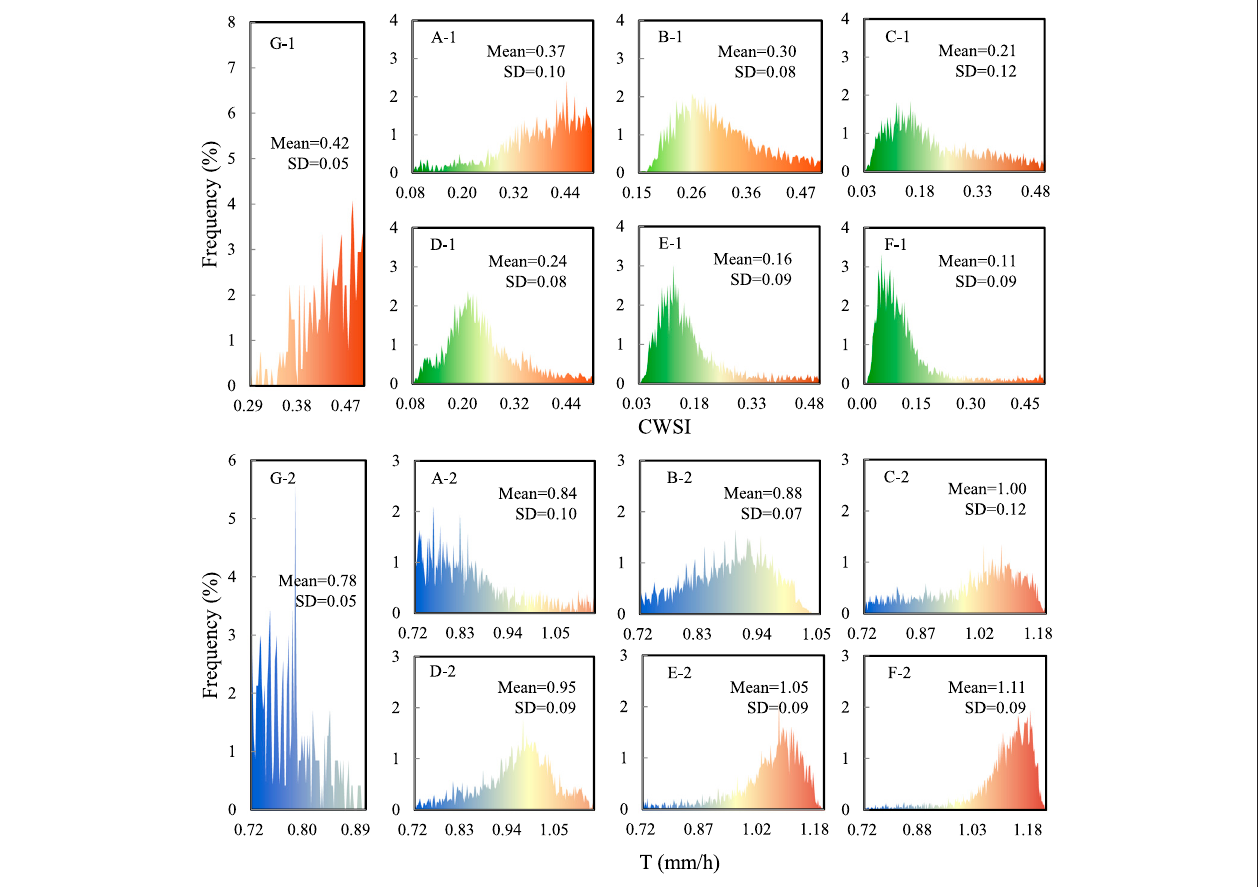
FIGURE7| Frequencydistributiondiagramforthe(1)cropwaterstressindexand(2)transpirationofalfalfaunderdifferentirrigationmethods: (A) R10, (B) R20, (C) R30, (D) P10, (E) P20, (F) P30, and (G) CK.